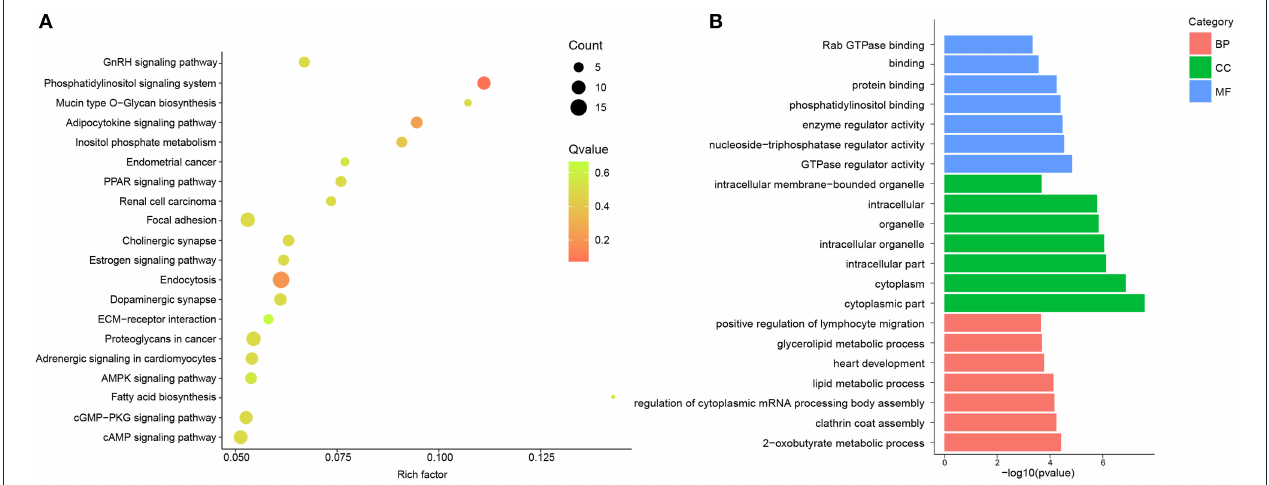
FIGURE 2 | GO and KEGG pathway analysis of DE circRNAs between and SHR and WKY rat aorta. (A) Top 20 KEGG pathways for DE circRNAs were identified in SHR and WKY rat aorta. (B) Top 7 GO enriched terms were analyzed for biological process (BP), cellular component (CC), and molecular function (MF), respectively. GO, gene ontology; KEGG, Kyoto encyclopedia of genes and genomes; DE, differentially expressed; circRNAs, circular RNAs; WKY, Wistar-Kyoto; SHR spontaneously hypertensive